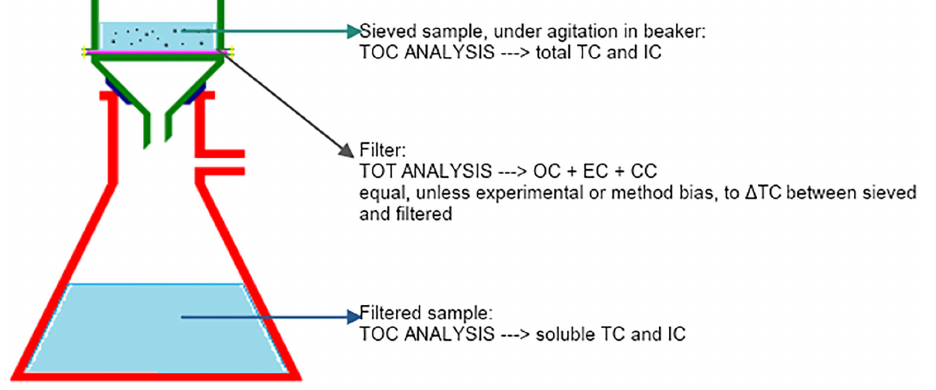
Figure 4. The work Figure 4. The work scheme.